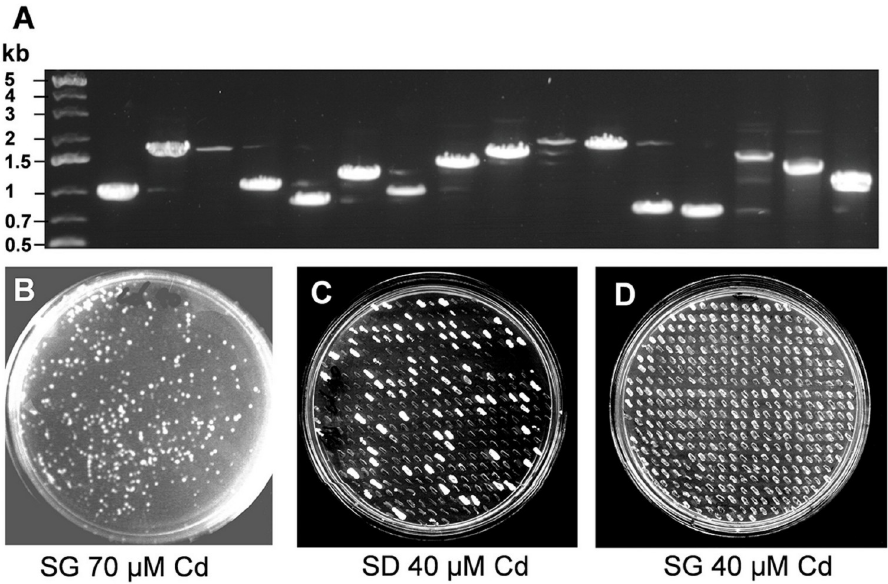
Fig 1. Screening of Cd tolerance gene in Brassica rapa . (A) Insert size of B . rapa cDNA library. Inserts of the B , rapa cDNA library in the pYES2 vector were amplified using PCR with vector linker primers, and electrophoresed in 1% agarose gel. (B) First selection of Cd tolerance genes in B . rapa . The Cd-sensitive yeast mutant (DTY167) was transformed with a cDNA library of B . rapa and grown on synthetic galactose (SG) agar plates supplemented with 70 μ M CdCl 2 to select clones harboring Cd tolerance genes. (C, D) Second selection of Cd tolerance genes in B . rapa . The surviving clones from the 1’st screening were grown on synthetic dextrose (SD) and synthetic galactose (SG) media supplemented with 40 μ M CdCl 2 to select real positive clones. False-positive clones surviving on SD supplemented with CdCl 2 were discarded. The clones growing on SG but not on SD were further